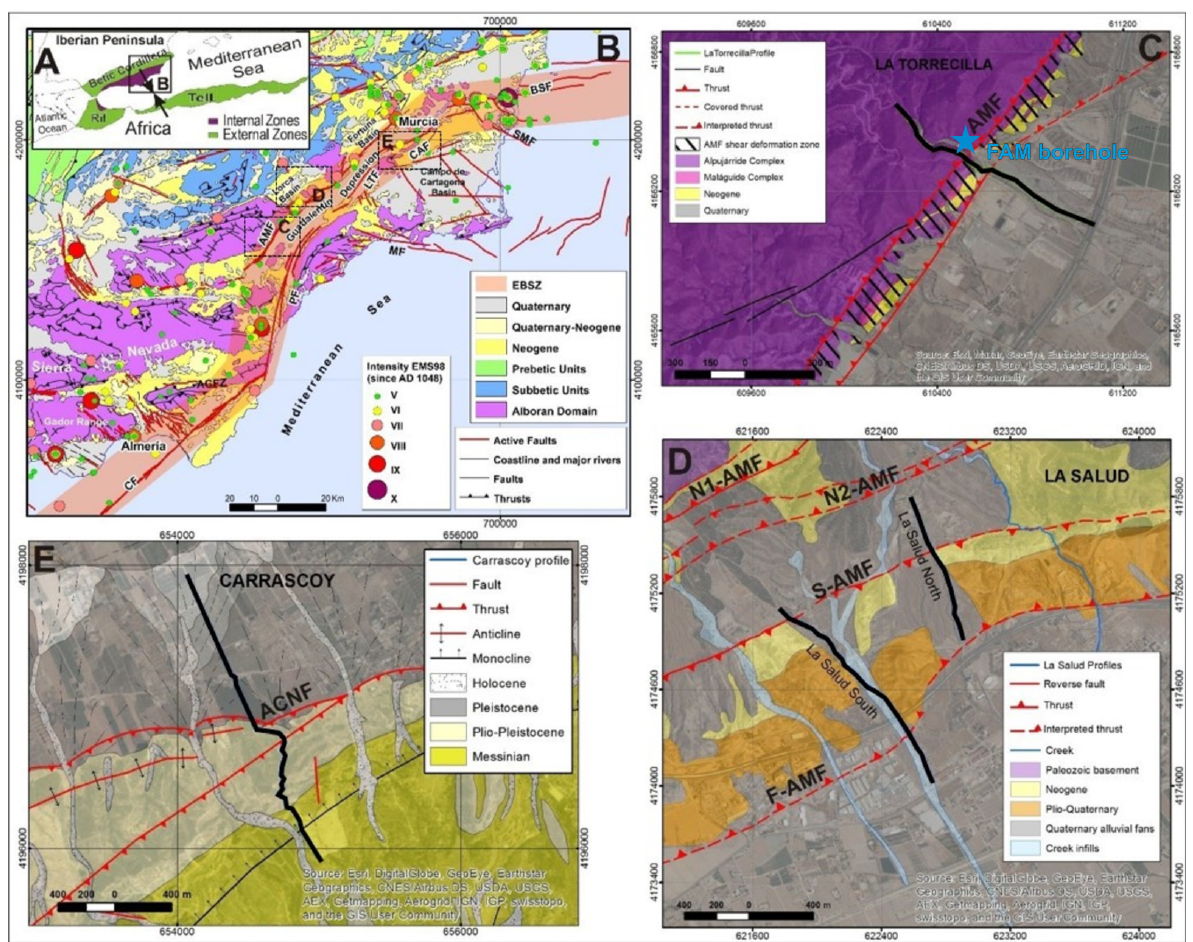
Figure 2. Geological setting of the study area. ( A ) Geodynamic frame of the study area. Arrows indicate the current approximation direction between Eurasian and Nubian plates. ( B ) Geological and seismological setting of the Eastern Betic Shear Zone (EBSZ); SMF: San Miguel de Salinas Fault; BSF: Bajo Segura Fault; CAF: Carrascoy Fautl; LTF: Los Tollos Fault; AMF: Alhama de Murcia Fault; PF: Palomares Fault; CF: Carboneras Fault; ACFZ: Alpujarrides Corridor Fault Zone; MF: Las Moreras- Escarpe de Mazarr ó n Fault. Geological mapping was carried out from Continuous Digital Maps at scale of 1:50.000 of the Internal Zones of the Betic Cordillera [45]. Active fault traces are from an updated version of QAFI database [46,47]. Earthquake data correspond to a declustered version of the Spanish national seismic catalog [48]. ( C – E ) represent the locations of Figure 2C–E. Geological setting of the La Torrecilla profile modified from Mart í nez-D í az et al. [49]. The blue star marks the position of the scientific borehole FAM-1. AMF: Alhama de Murcia Fault. ( D ) Geological setting of the La Salud North and La Salud South profiles modified from G ó mez-Novell [43]. N1-AMF, N2-AMF, S-AMF, and F-AMF are the names of the different strands of the AMF in this sector. ( E ) Geological setting of the Carrascoy profile modified from Mart í n-Banda et al. [44]. ACNF: Algezares-Casas Nuevas